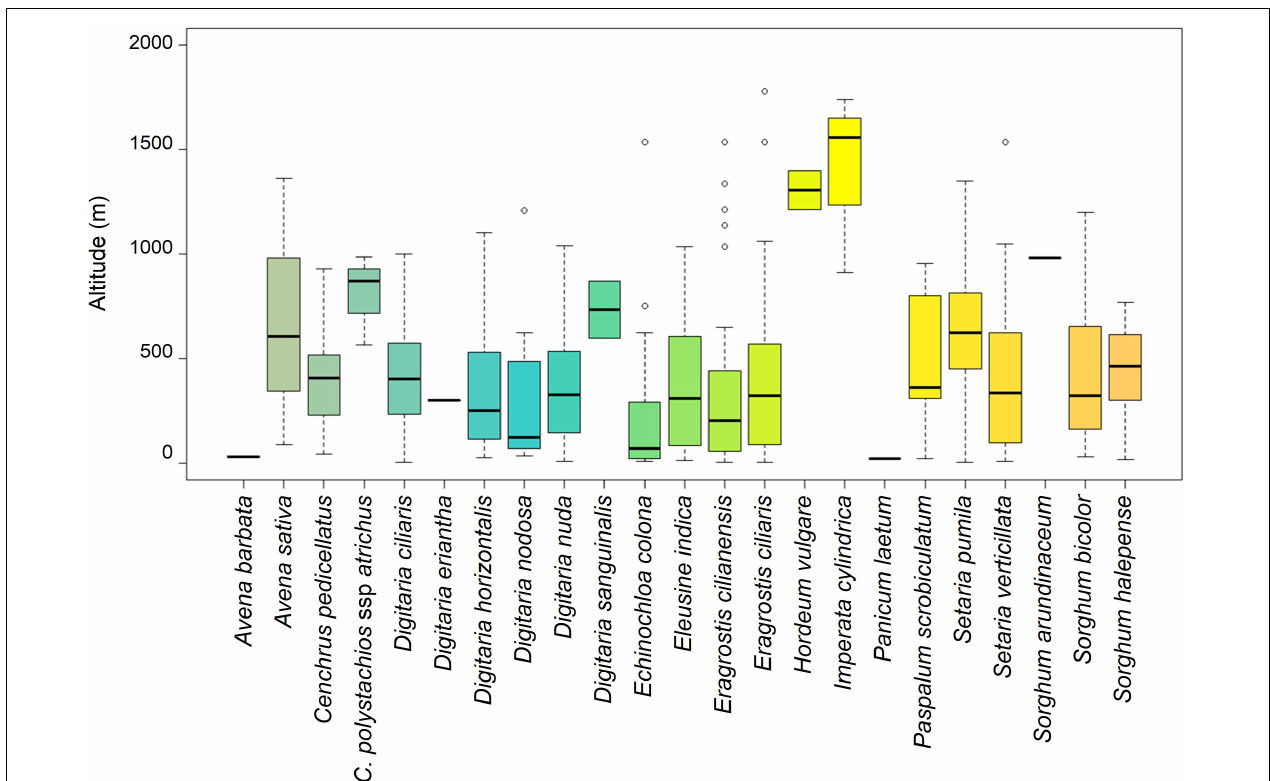
FIGURE 2 | Altitudinal distribution of CWR records in Cabo Verde Islands. The boxplots show the minimum (at the bottom of the chart, at the end of the vertical line), first quartile, Q1, (the bottom edge of the box), the median (line in the center of the box), third quartile, Q3 (the top edge of the box), the maximum (at the top end of the vertical line), and outliers (circles). Species represented with a single line have only one recorded occurrence. Species without records ( Avena fatua, Echinochloa crus-galli and Eragrostis pilosa ) were not included in this